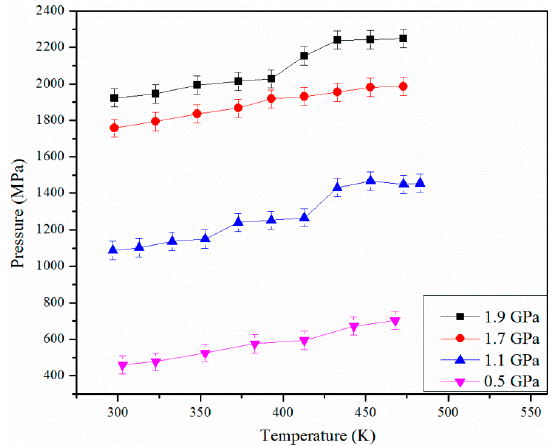
Figure 7. Various initial pressures, pyrite heating in HDAC from 298 K–493 K, in situ pressures (0.5, 1.1, 1.7, 1.9 GPa) at every temperature point. Error bars show pressure uncertainty is ± 50 MPa.